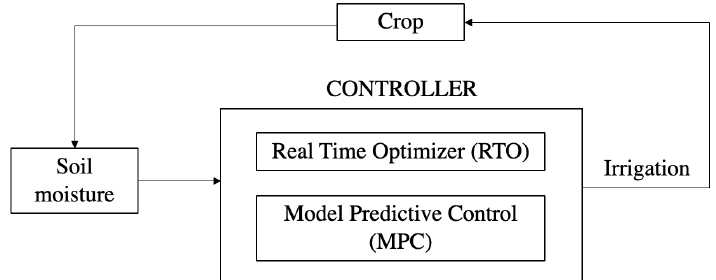
Figure 2. Schematic diagram of the proposed predictive controller (RTO +